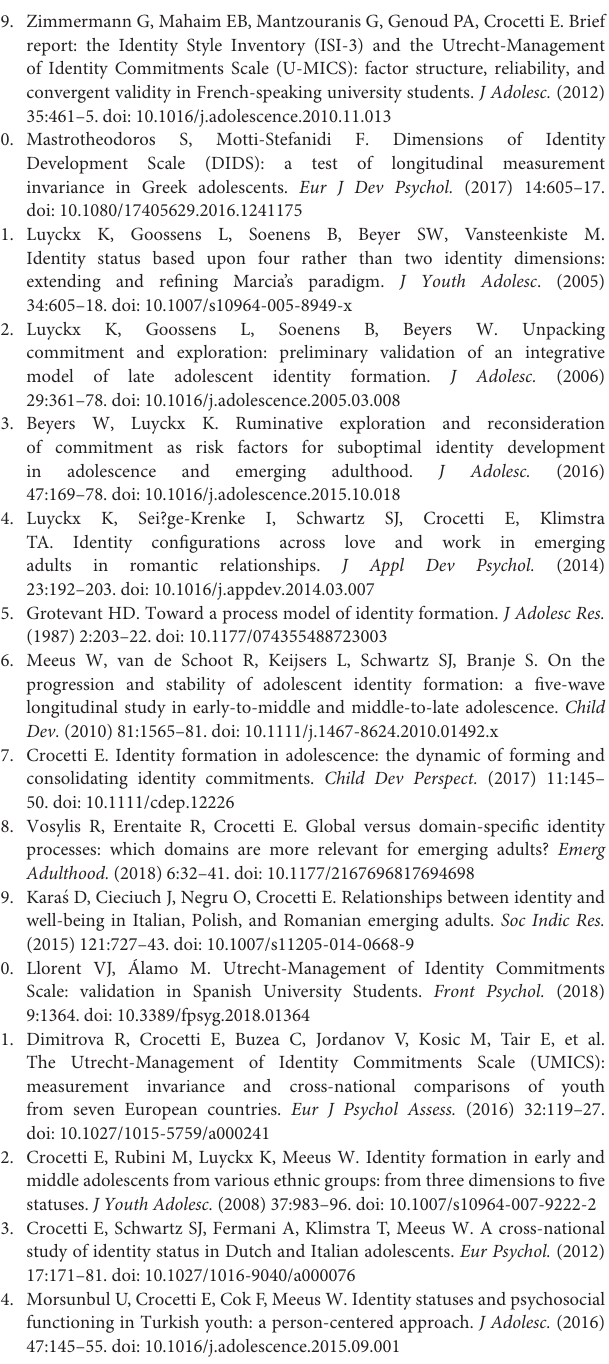
Supplementary Table 4 | The relationship between H-DIDS and H-UMICS (relational identity) classifications. Note: Undif = Undifferentiated cluster; Diff = Diffusion cluster; Ach = Achievement cluster; Fore = Foreclosure cluster; Mor =